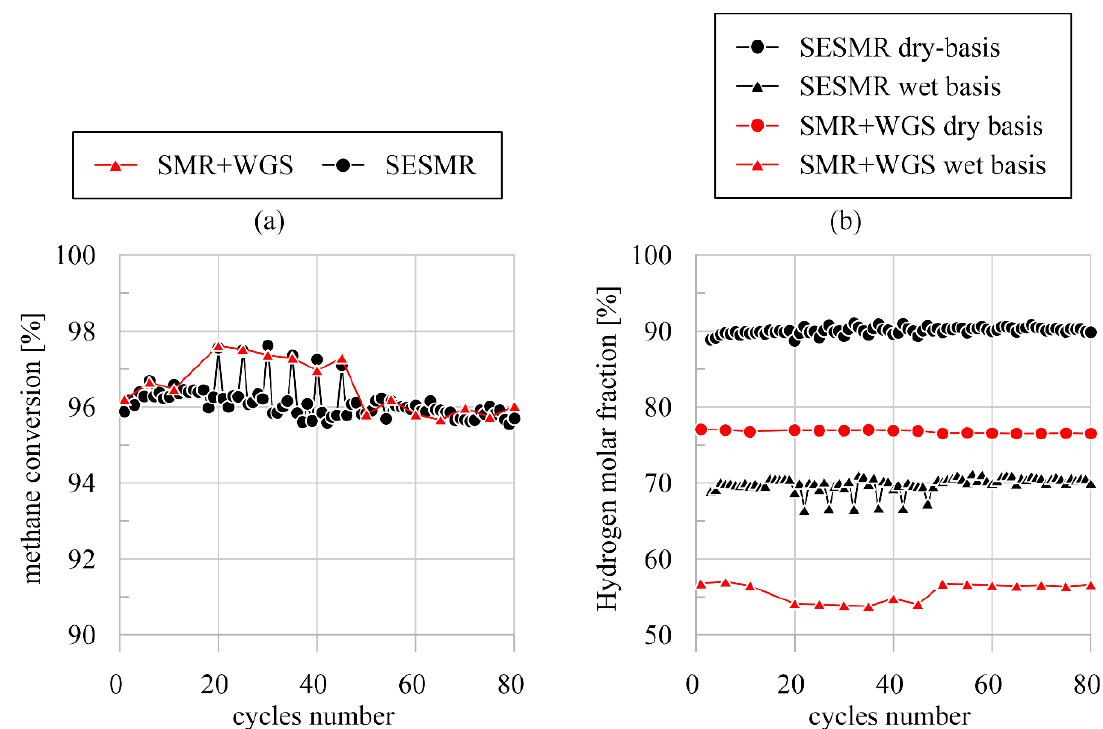
Figure 2. Methane conversion ( a ) and hydrogen molar fraction dry and wet basis for SESMR and SMR+WGS ( b ). Data adapted from Di Giuliano et al. [63].